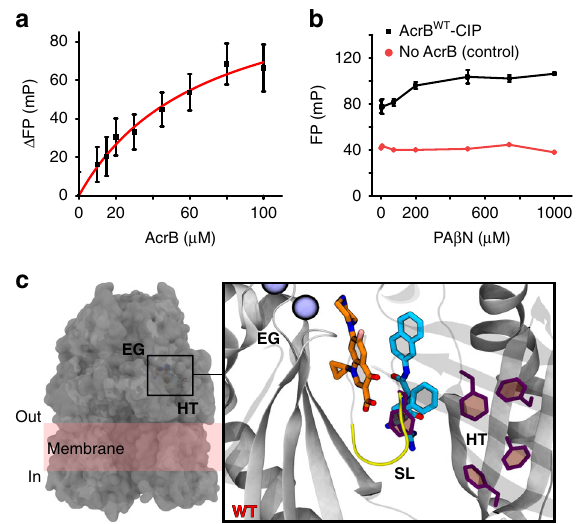
Fig. 3 Dual binding of cipro fl oxacin antibiotic and PA β N inhibitor to the DBP of AcrB WT . a Binding of CIP by AcrB WT in the presence of 150 μ M of PA β N as determined by a fl uorescence polarization assay performed by Su et al. 39 . CIP was maintained at 1.5 µ M throughout and its emission wavelength measured at 415 nm. Reported data are the average and standard deviation from independent measurements ( n = 3) and were fi tted to a hyperbola function (FP = ( B K + [protein]), max *[protein])/( D R 2 = 0.98). b Binding competition assay between PA β N and CIP for AcrB WT . PA β N was non ‐ fl uorescent in the experimental conditions. Data are the average and standard deviation from independent measurements ( n = 3). c Molecular docking and multi-copy μ s-long MD simulations reveal stable interactions of CIP (orange) and PA β N (cyan) to AcrB WT T-state monomer and show their likely binding locations. EG = exit channel gate (blue spheres), SL = switch-loop (yellow), and HT = hydrophobic trap (purple). All computational data can be found in Supplementary Table 2 and Supplementary Figs. 8,